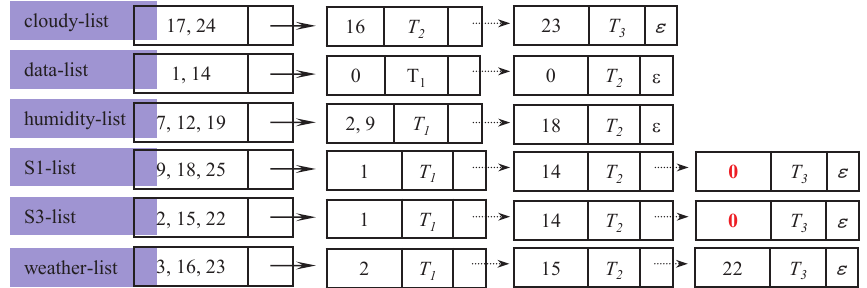
Figure 6. L after pruning infrequent label dic